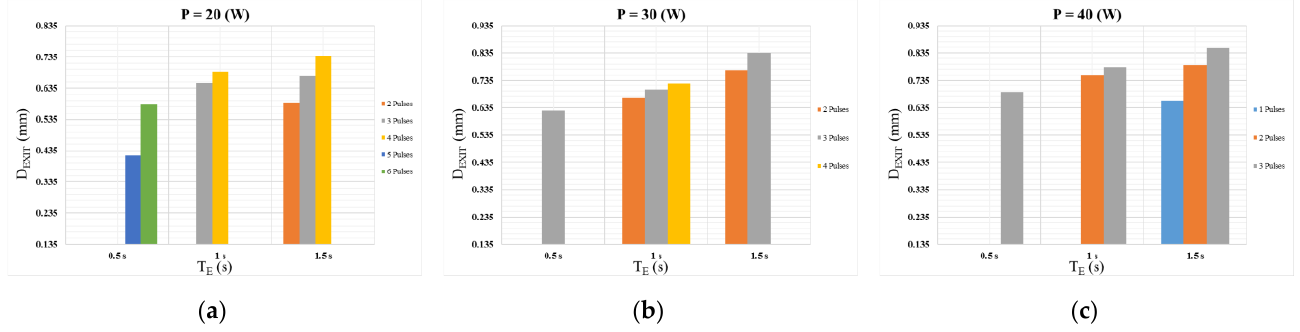
Figure 11. Influence of T E and N P on D EXIT for 0.05 wt.% of CNPs and ( a ) P = 20 W, ( b ) P = 30 W and ( c ) P = 40 W.